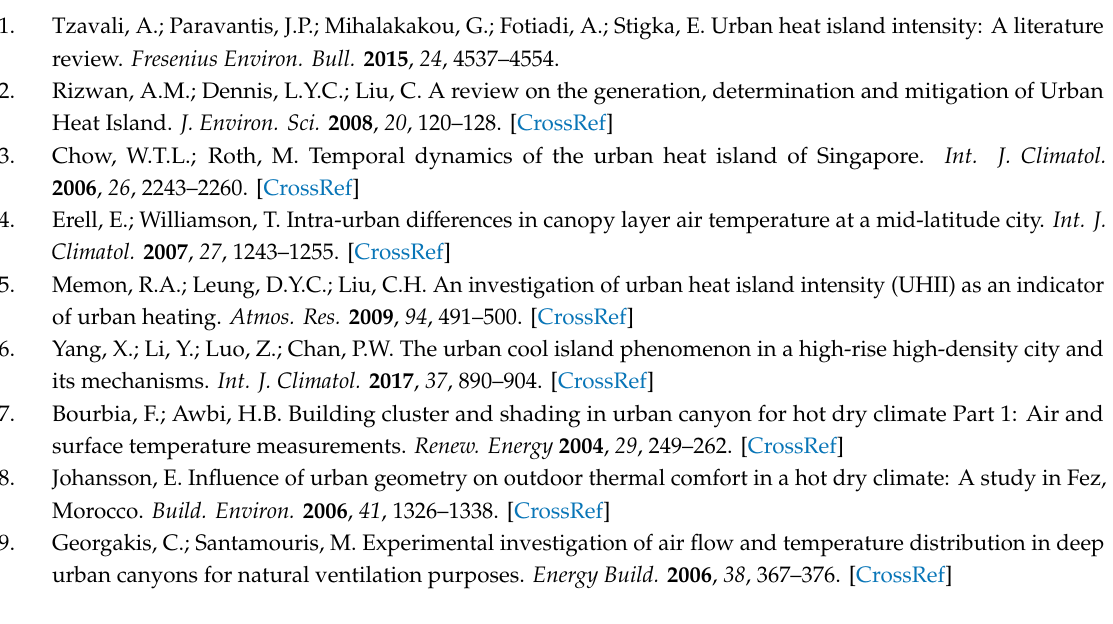
Figure A1. Di ff erence between T s calculated using emissivity value of 0.95 and that calculated using other emissivity values (1 and 0.9): ( a ) daytime and ( b ) after sunset. The di ff erence for emissivity 1 is depicted with red line, and that for emissivity 0.9 is depicted with blue line. The di ff erence indicates the uncertainty of T s used in the present study (i.e., calculated using emissivity value of 0.95): T s used in the present study was higher (lower) than the actual T s if the actual emissivity of the surface was 1 (0.9).